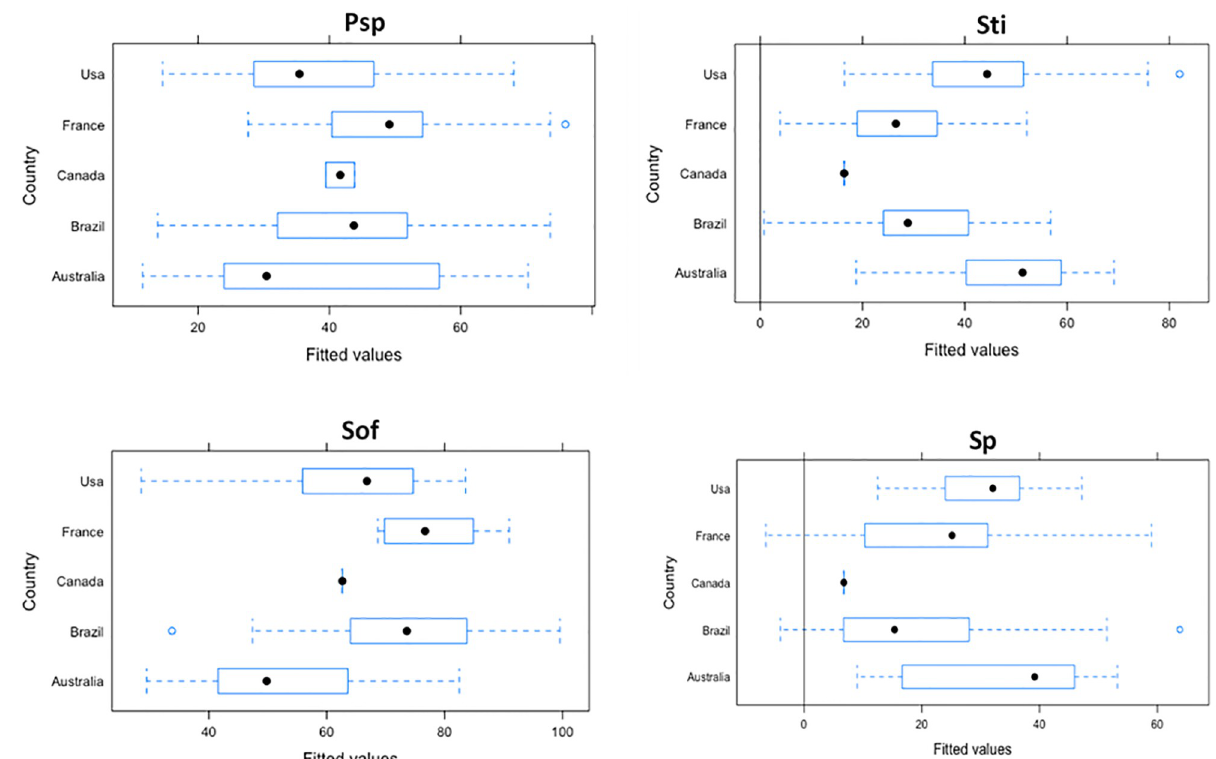
Fig 2. Variation of scores due to random effect among